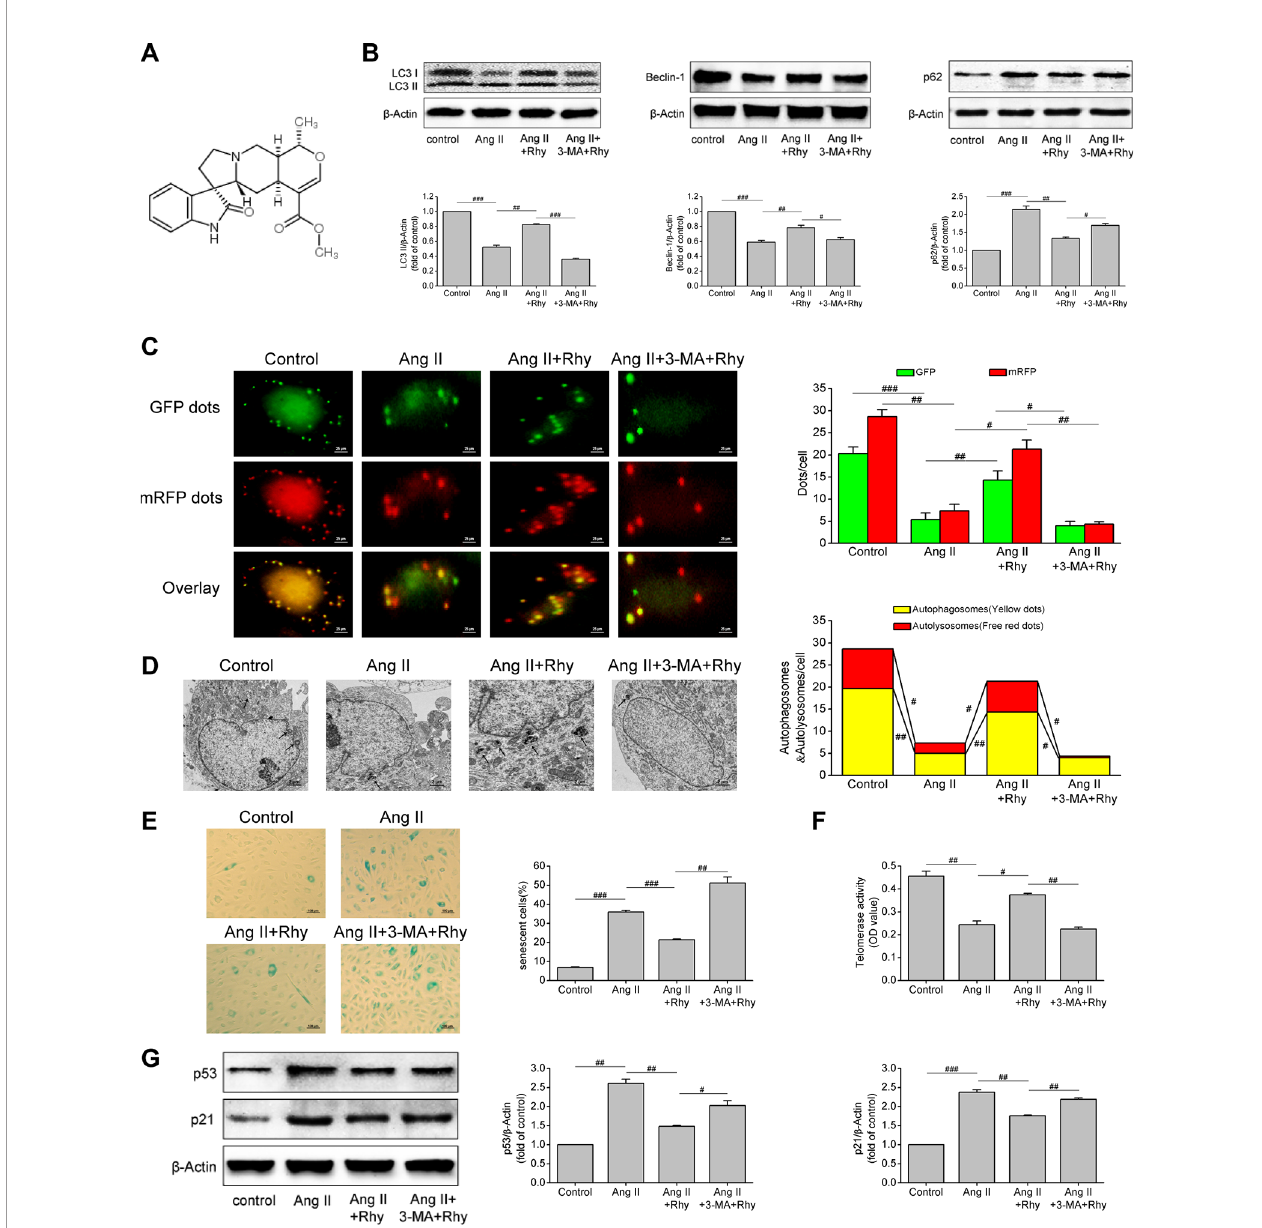
FIGURE 4 | Rhynchophylline enhanced autophagy and attenuated Ang II-induced EPCs senescence. (A) The chemical structure of Rhy. (B) Western blot analysis of LC3-II, beclin-1 and p62 expression in EPCs in indicated groups. The data was presented in fold of control. (C) Representative images and quantitative analysis of mRFP-GFP-LC3 immuno fl uorescence (400× magni fi cation). (D) Autophagosomes were observed by transmission electron microscopy. (E) Representative images and quantitative analysis of SA- b -gal activity assay (100× magni fi cation). (F) Telomerase activity was determined by telomeric repeat ampli fi cation protocol assay and indicated by the difference value (OD = A450-A690). (G) Western blot analysis of p53 and p21 expression in EPCs in indicated groups. The data was presented in fold of control. All data were pooled as mean ± S.D. (error bars) from three independent biological repeats experiments, each of which included 4 technical repeats. # P < 0.05; ## P < 0.01; ### P <